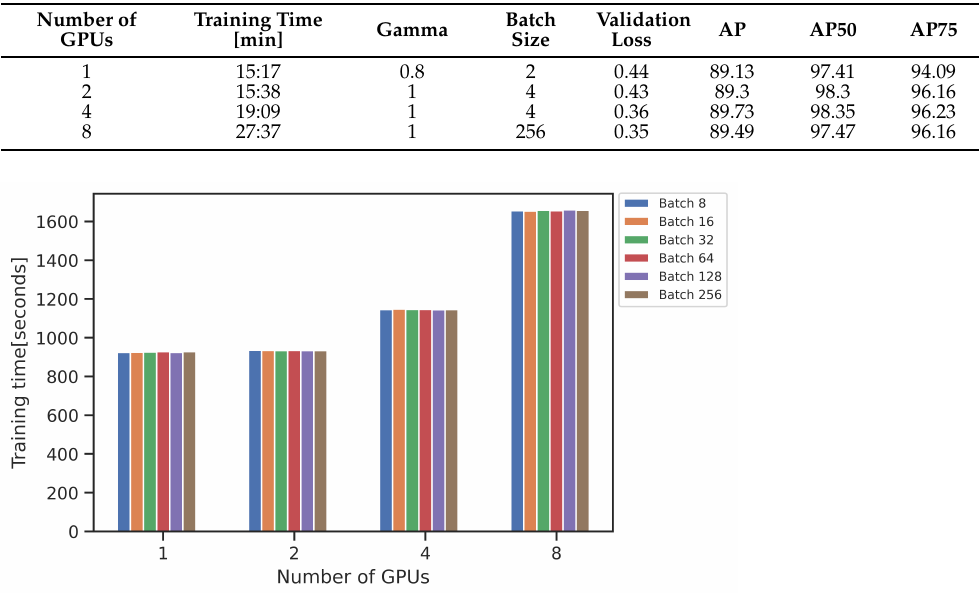
Table 4. Instance segmentation, hyperparameter optimization results for mask_rcnn_R_101_FPN_3x, 1000 epochs, for different values of gamma and batch sizes.